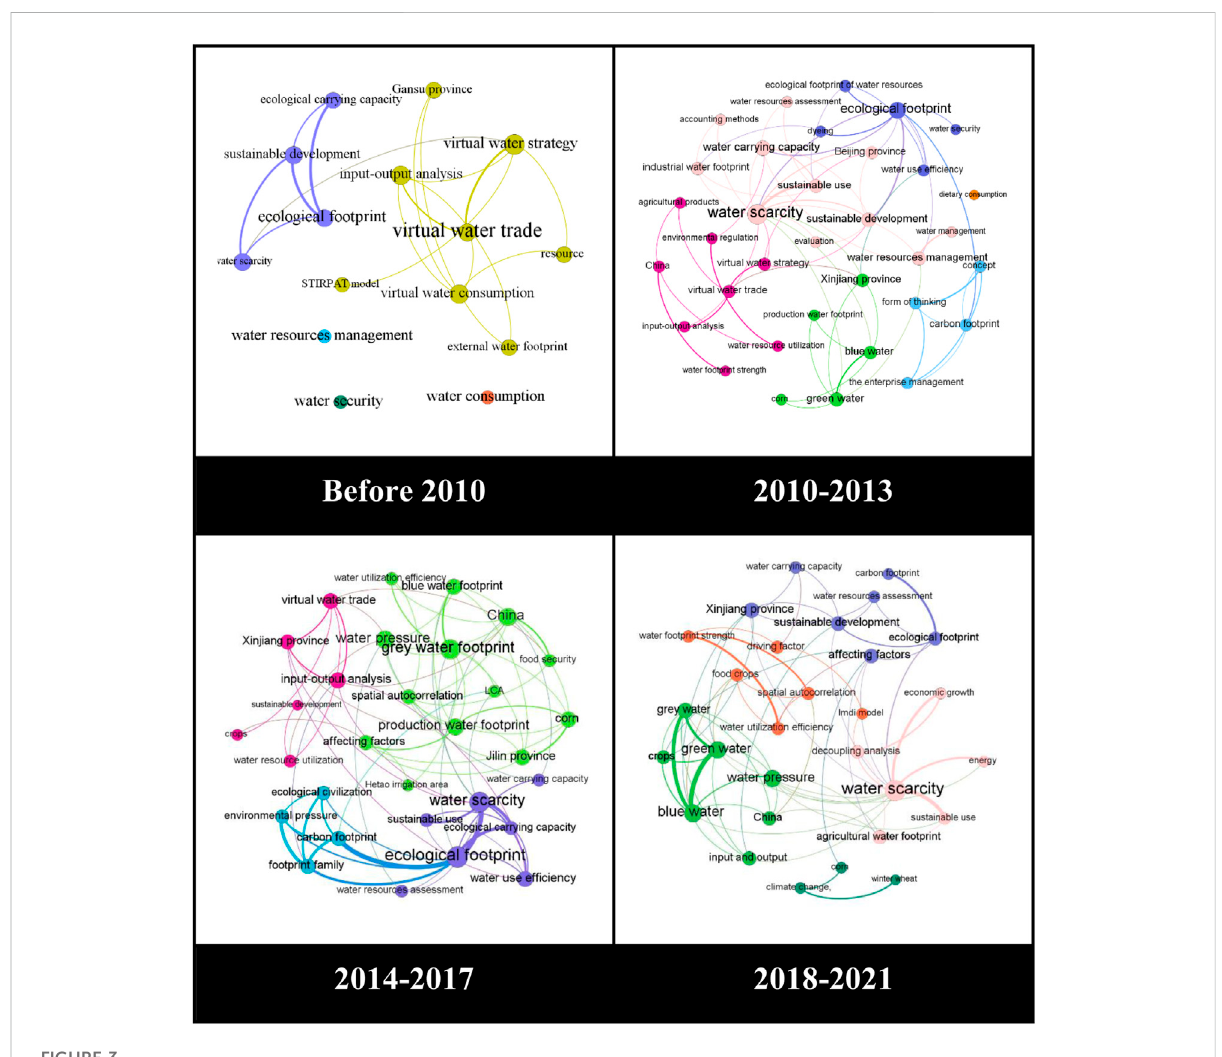
The evolutionary co-words network of water footprint from